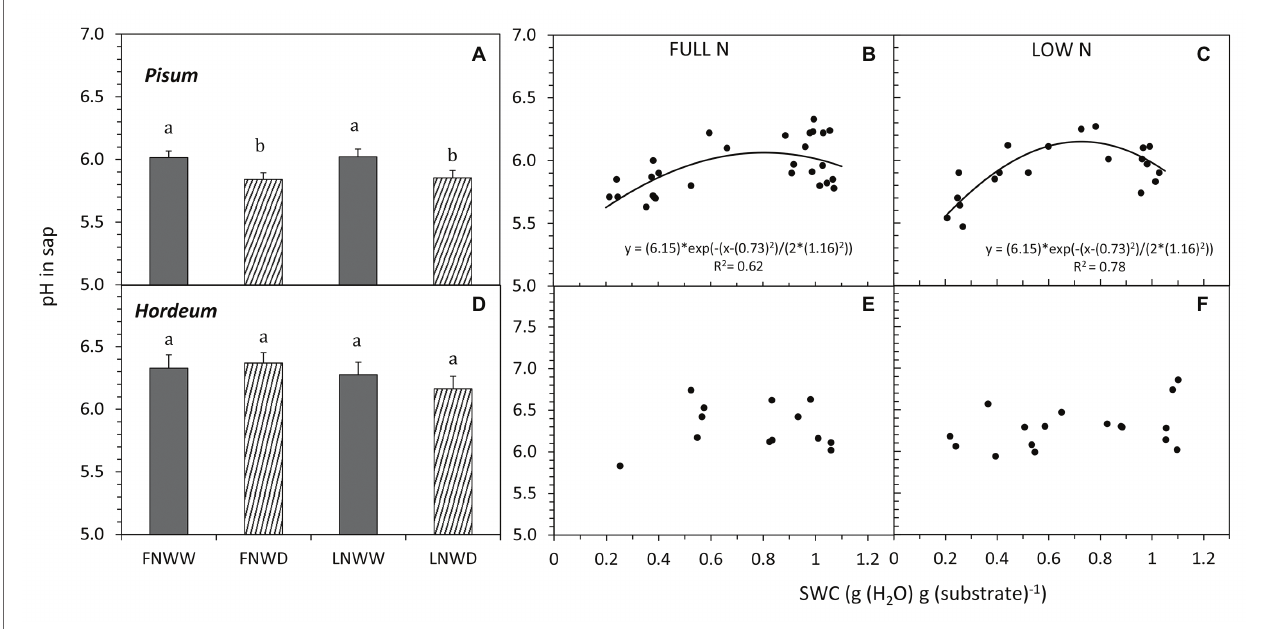
FIGURE 6 | Mean pH in xylem sap (pH in sap) of P. sativum (A,B,C) and H. vulgare (D,E,F) plants after 2–6 days of treatments with different water and nitrogen availability. FNWW plants received 4 mM NO3 − daily, FNWD plants received 4 mM NO3 − at the start but no water during the sampling period, LNWW plants received 0.2 mM NO3 − daily, and LNWD plants received 0.2 mM NO3 − at the start but no water during the sampling period. The graphs (A,D) show means in each treatment ± SE ( n = 6–17). Significant differences ( p ≤ 0.05) between treatments were tested separately for each species and are marked by different letters. Dynamic changes of pH in sap with declining SWC are shown in (B,C) for P. sativum ; (E,F) for H. vulgare under full (FN) and low (LN) NO3 − availability. Significant relationships are marked by a regression line with the corresponding equation. FN, full nitrogen; LN, low nitrogen; WW, well-watered; and WD, water